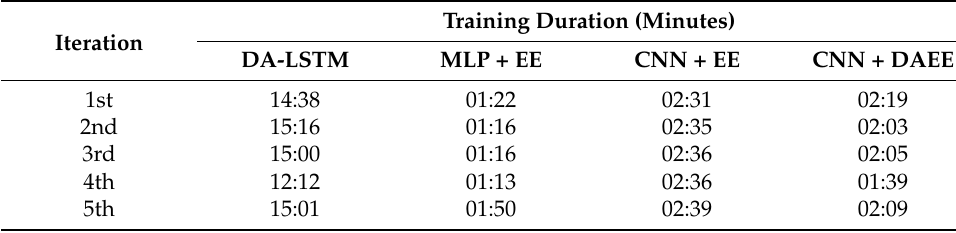
Figure 9. Comparison of results of four models for 100 sample test set in third iteration of CV. Table 9. Training duration in hours: minutes